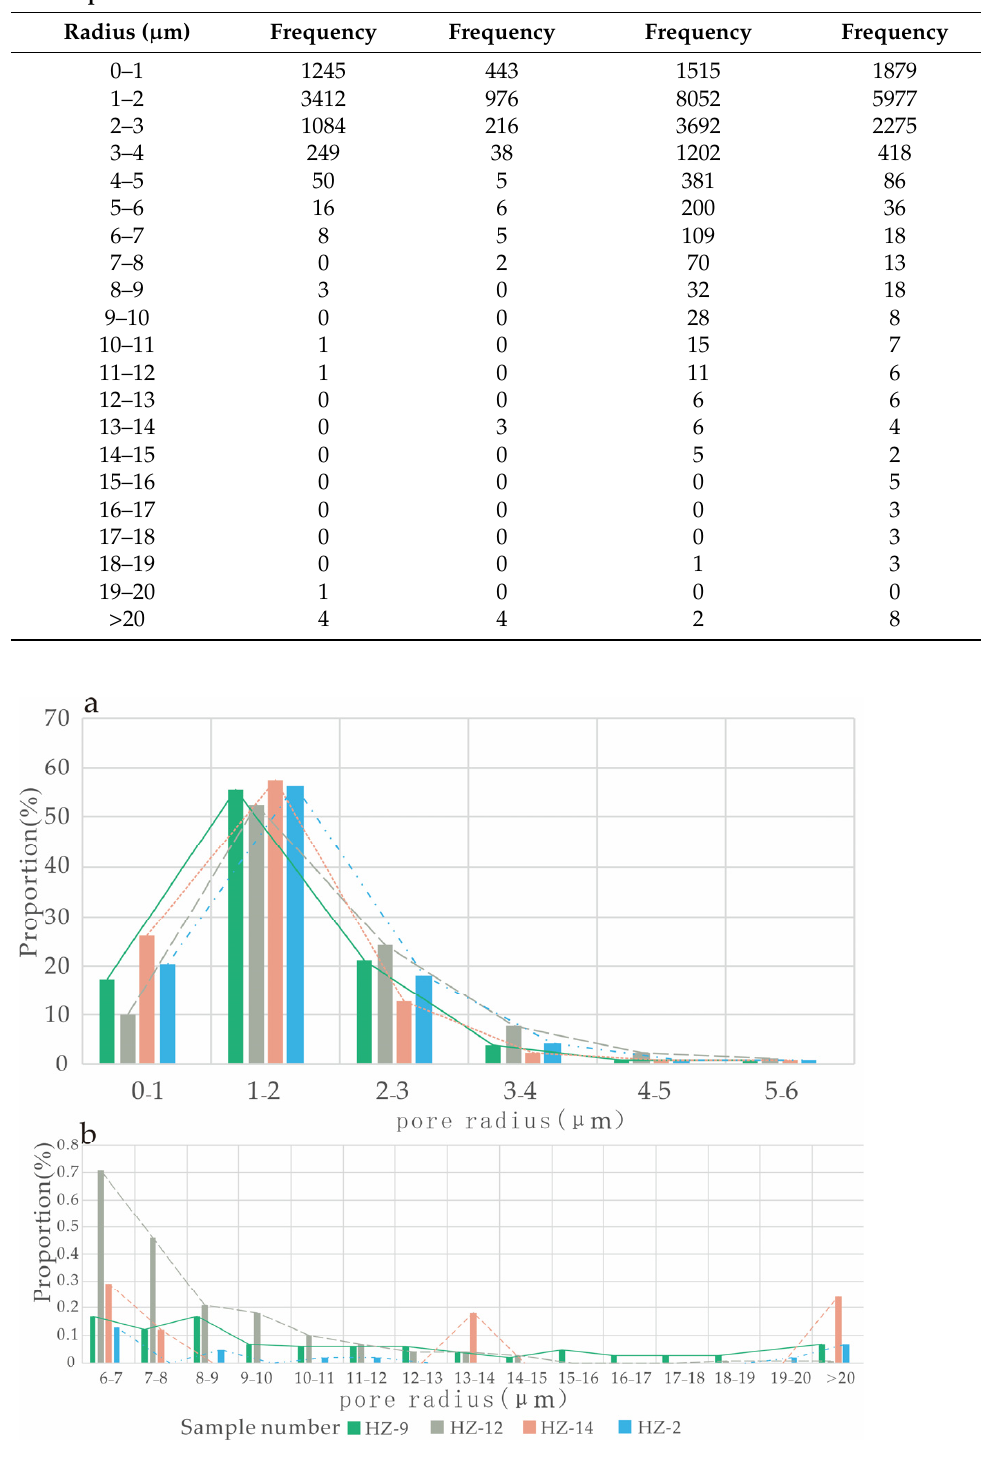
The number of pores with a radius larger than 20 µ m in HZ-2 was the largest among all the samples (Table 3 and Figure 8). Table 3. Test results of the pore radius of the carbonate rock samples in the Huize lead–zinc deposit. Sample Number